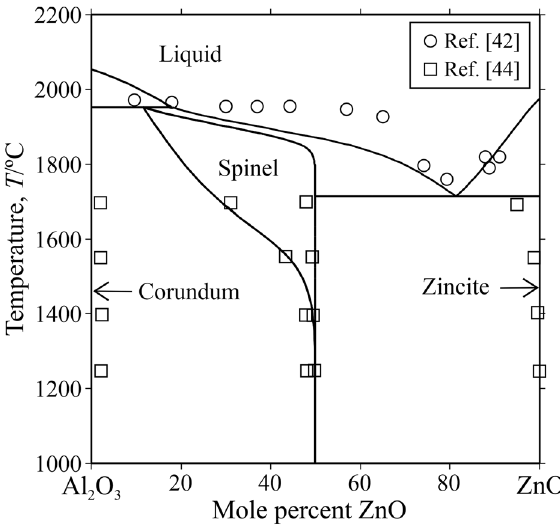
Figure 1: Calculated phase diagram of the Al 2 O 3 – ZnO